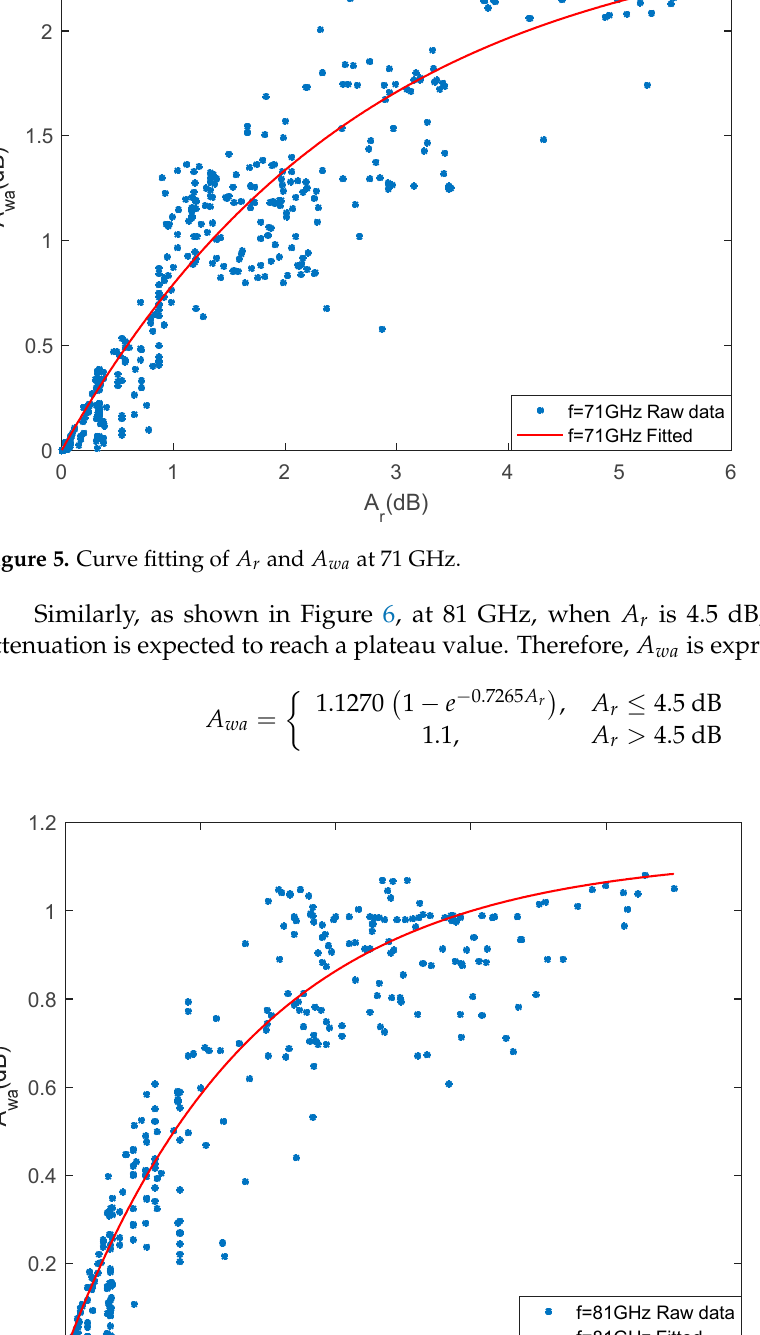
Figure 7. Rain-induced attenuation at 71 GHz on 7 January 2020, black line: rain-induced attenua- tion after correction; blue line: predicted from link data; red line: estimated from DSD data; green line: using the method recommended by ITU-R P.838-3.